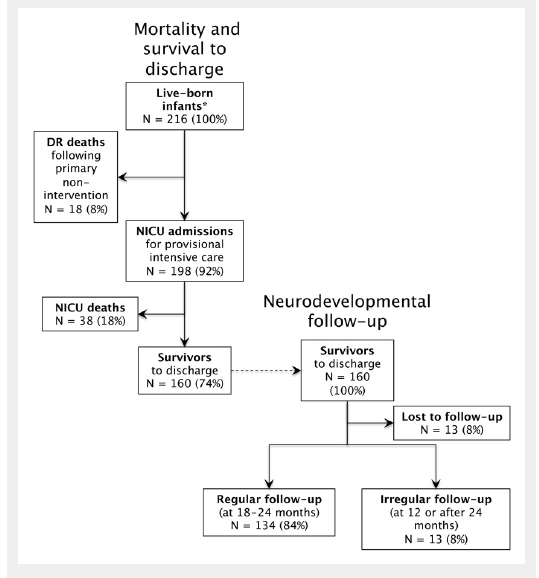
Circumstances of death in ELGANs who died in the DR. CNS = central nervous system; TTTS = twin-to-twin transfusion syndrome. * Late termination of